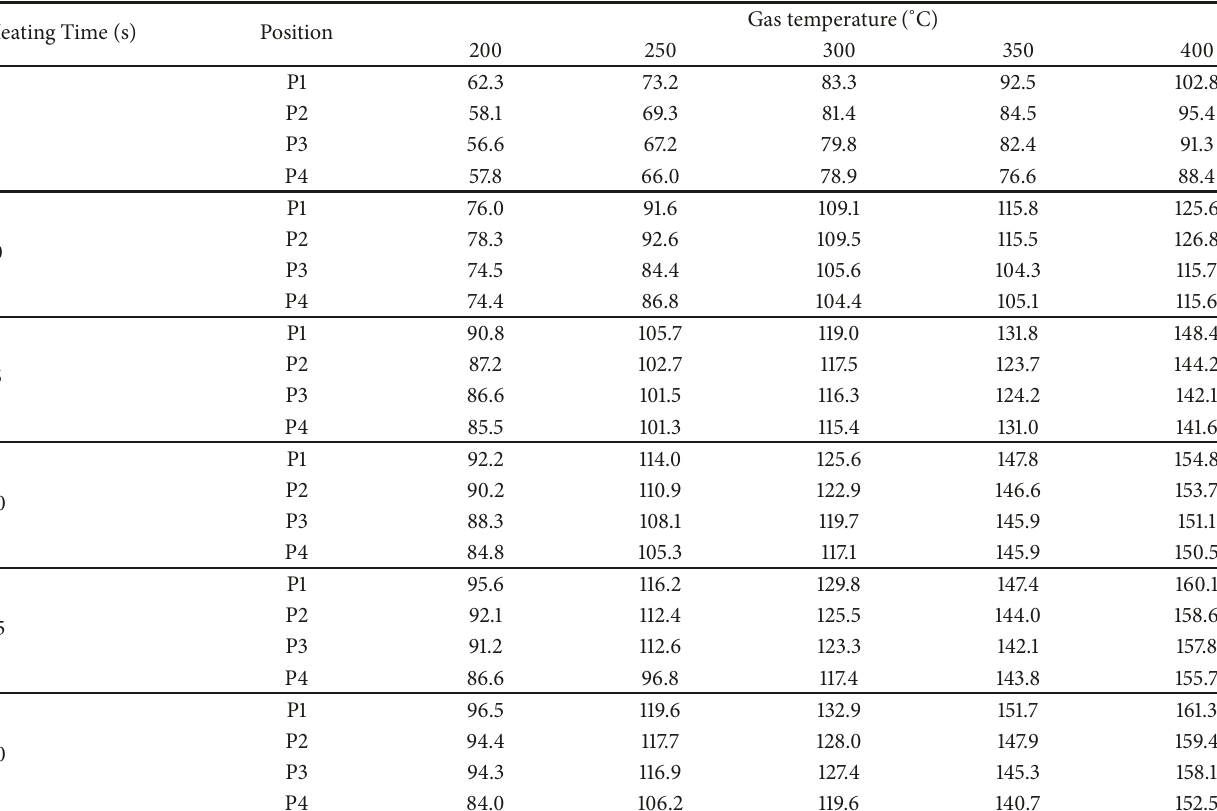
Table 2: Simulation results of mold cavity temperature after heating for the melt flow length